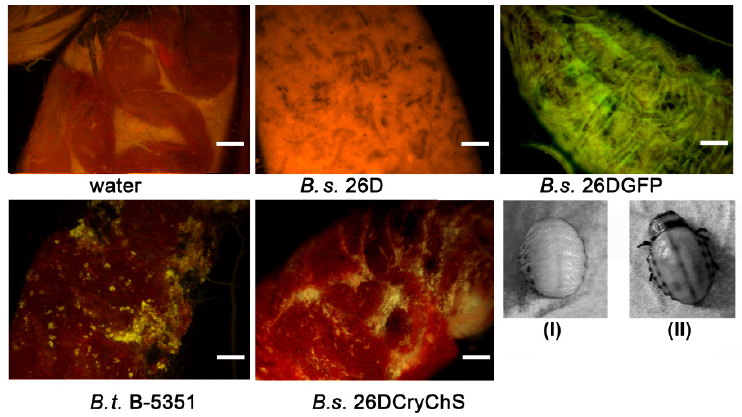
Figure 3. Mesenteron structure of L. decemlineata beetles 24 h after feeding of potato plants, which contained cells of Bacillus strains. Scale bars, 200 um. ( I ) Healthy larva; ( II ) bacteriosis on alive larva on the 5th day after eating of plants containing Bacillus sp.